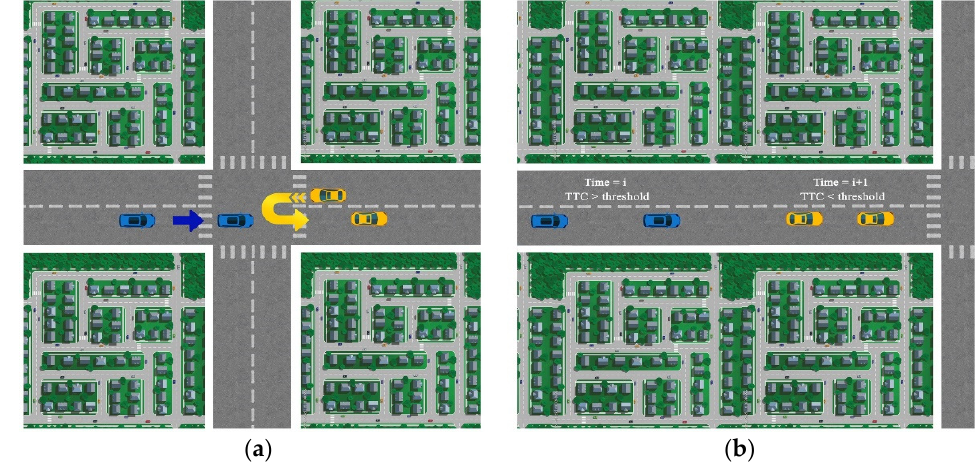
Figure 2. examples of merging and lead/follow conflicts: ( a ) example of merging conflicts; ( b ) example of lead/follow conflicts. Figure 3 shows two examples of crossing conflicts in two different situations.